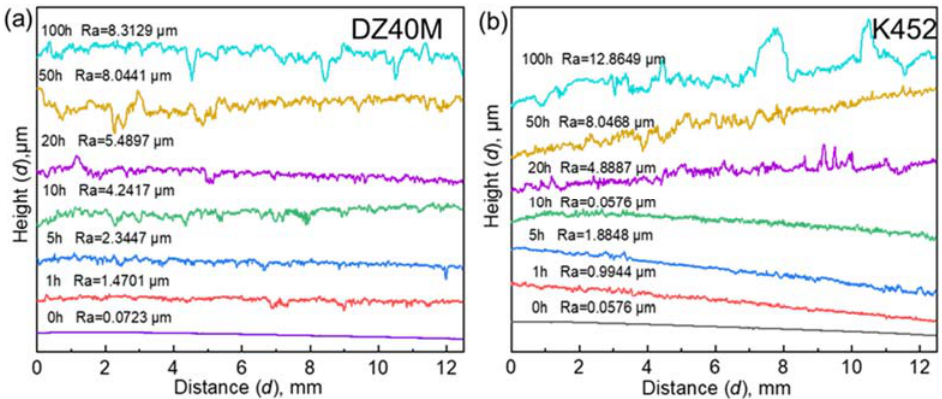
Figure 13. Substrate roughness of DZ40M and K452 after hot corrosion. ( a ) DZ40M, ( b ) K452.